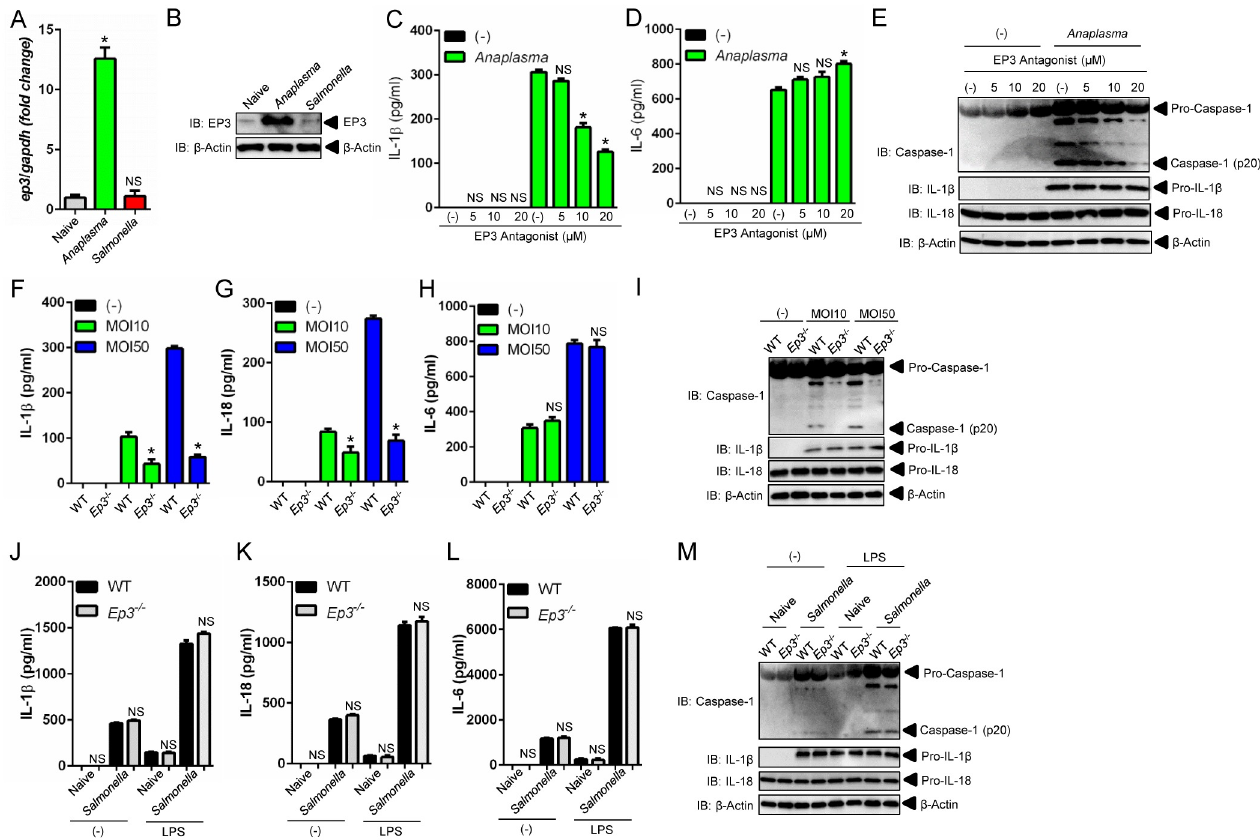
Fig 9. The PGE 2 -EP3 axis regulates activation of the NLRC4 inflammasome upon A . phagocytophilum infection. (A-B) Wildtype (WT) BMDMs (1 x10 6 cells) were infected with A . phagocytophilum (MOI50) for 18 hours or Salmonella (MOI25) for 1 hour. RNA and protein levels of the PGE 2 -EP3 receptor was measured by qRT-PCR and western blot (IB). β -actin was also detected in cell lysates. (C-E) WT BMDMs (1 x10 6 cells) was pre-treated with the EP3 antagonist (L-798106) for 30 minutes at indicated concentrations followed by A . phagocytophilum colonization (MOI50) for 18 hours. The levels of (C) IL-1 β and (D) IL-6 were measured in cell culture supernatants by ELISA. (E) Caspase-1 autoproteolysis in cell culture supernatants. pro-IL-1 β , pro-IL-18 and β -actin were detected in cell lysates by SDS-PAGE immunoblots (IB). (F-H) WT and Ep3 -/- BMDMs (1 x10 6 cells) were infected with A . phagocytophilum (MOI 10/50) for 18 hours. The levels of (F) IL-1 β , (G) IL-18 and (H) IL-6 in culture supernatants were measured by ELISAs. (I) Caspase-1 autoproteolysis in cell culture supernatants. pro-IL-1 β , pro-IL-18 and β -actin were detected in cell lysates by SDS-PAGE immunoblots (IB). (J-M) Na ï ve or LPS-primed (50 ng/ml) WT and Ep3 -/- BMDMs (1 x10 6 cells) were infected with Salmonella (MOI25) for 1 hour. The levels of (J) IL-1 β , (K) IL-18 and (L) IL-6 in cultured supernatants were measured by ELISA. (M) Caspase- 1 autoproteolysis in cell culture supernatants. pro-IL-1 β , pro-IL-18 and β -actin were detected in cell lysates by SDS-PAGE immunoblots (IB). Student ’ s t test and ANOVA-Tukey. * P < .05; NS, not significant. (-)